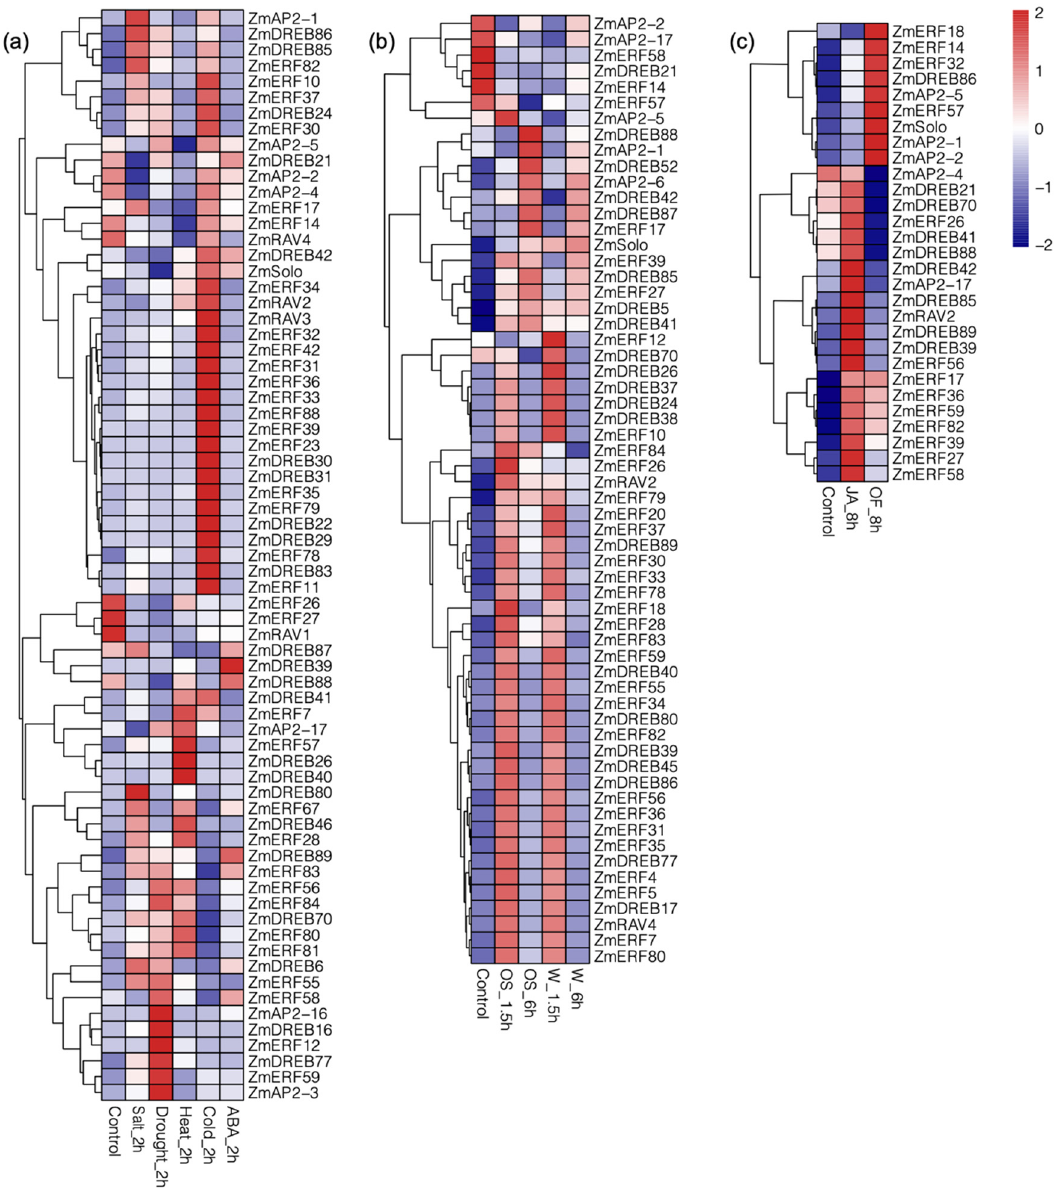
Figure 5. Expression quantification of ZmAP2 / ERFs under abiotic, biotic, and phytohormone treat- ment. ( a ) Expression analysis of ZmAP2 / ERFs in the response to drought, heat, cold, and ABA treat- ments. ( b ) ZmAP2 / ERF gene expression in response to wounding and OS treatment shown by heat map. ( c ) Heat map showing expression of ZmAP2 / ERF genes with JA and OF treatments.